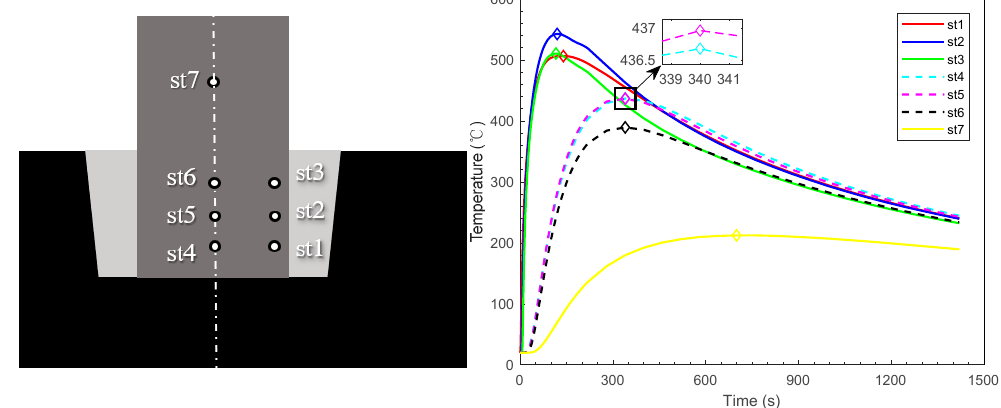
Figure 19. Schematic picture of the points selected in the stub and the cooling curves.